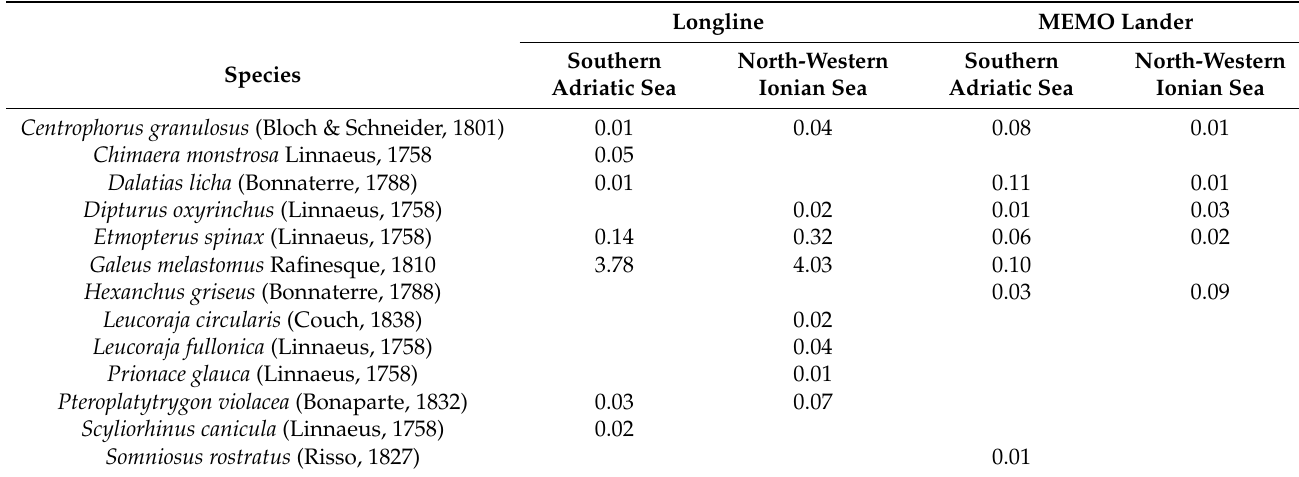
Table 2. Mean abundance (N/h) of cartilaginous fishes collected in the southern Adriatic and north-western Ionian Sea using longline and MEMO baited lander. Longline MEMO Lander Southern Species Adriatic